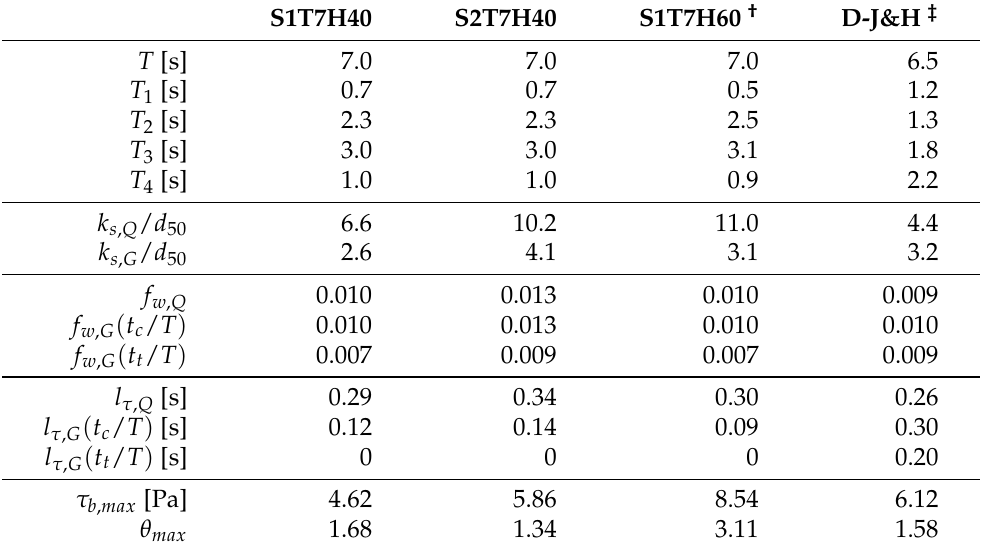
Table 3. A summary of parameters for bed shear stress from four different SedWaveFoam wave flume